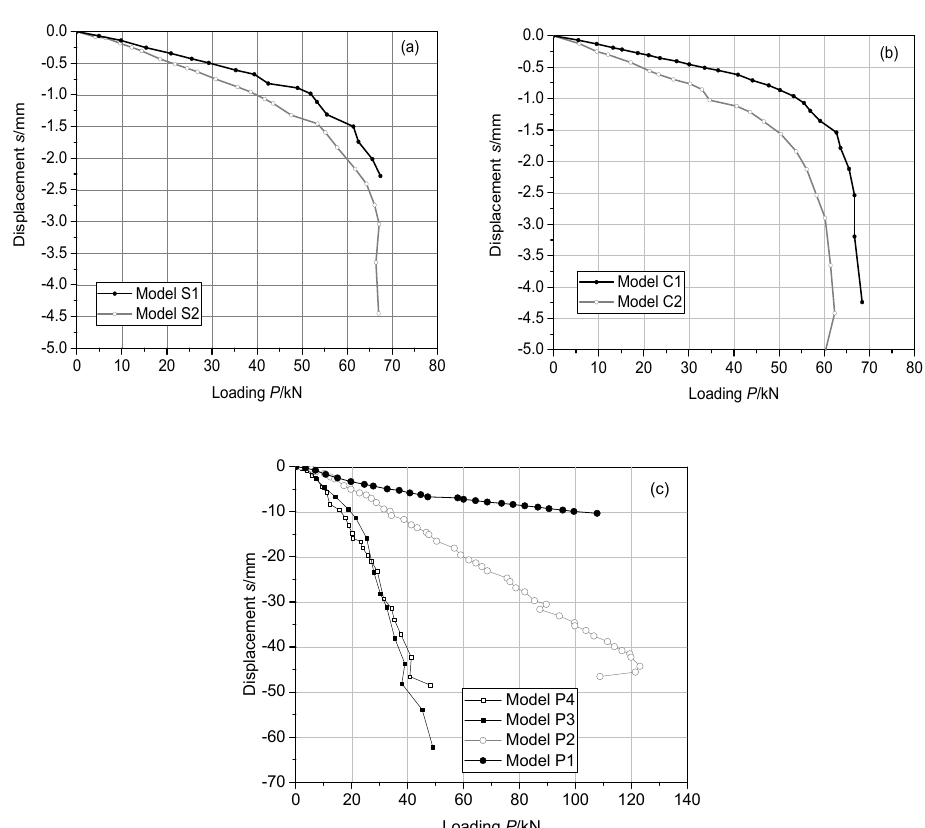
Figure 17. SLT P - s curves of the ( a ) spread; ( b ) caisson; and ( c ) grouped pile foundations. During the SLT, the P – s curve exhibits a linear relationship at the initial loading stage. Figure 18 illustrates the initial loading stages and corresponding linear fitting results of the three types of foundations. The correlation coefficients are greater than 0.99 for the spread and caisson foundations and exceed 0.97 for the grouped pile foundations. Then, the fitting results were used to calculate the static stiffnesses.